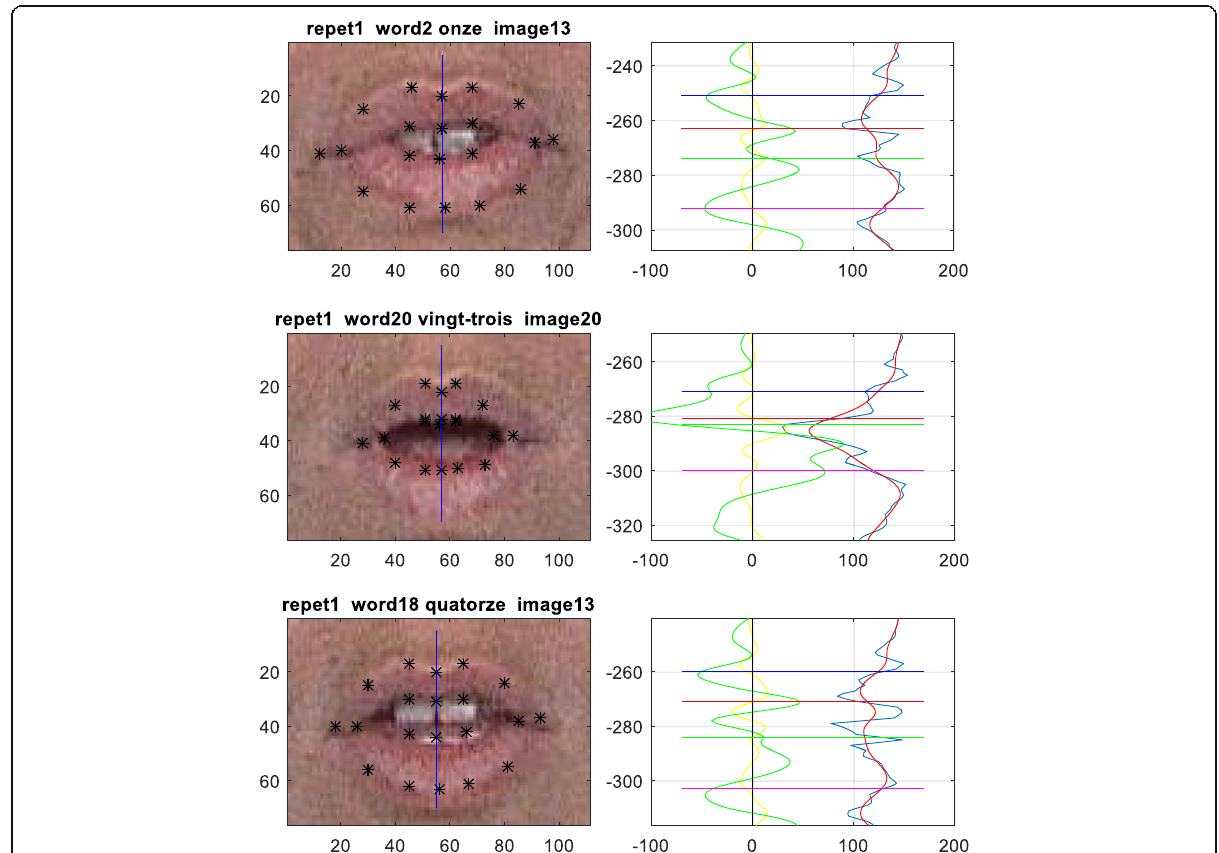
Fig. 7 The left figure shows lips ROI with CLNF lips landmarks (20 black stars ). The blue line in the left figure corresponds to the middle point of the inner lower lips , and all the curves in the right figure are plotted according to this blue line . On the right figure, the blue curve is the original luminance variation. The red curve is the smoothed luminance. The green curve is the first derivative of the smoothed luminance. Four lines with blue , red , green , and magenta colors correspond to four middle CLNF landmarks around the blue middle line in the left figure. In ( a ), the luminance decreases from the teeth to lower lips which corresponds to a local minimal point in the right figure. In ( b , c ), it becomes complicated to find the local minimal point corresponding to lower inner lips boundary. However, the outer lower lips boundary is always corresponding to a local minimal point on the local “ V ” curve in the right figure for these three cases